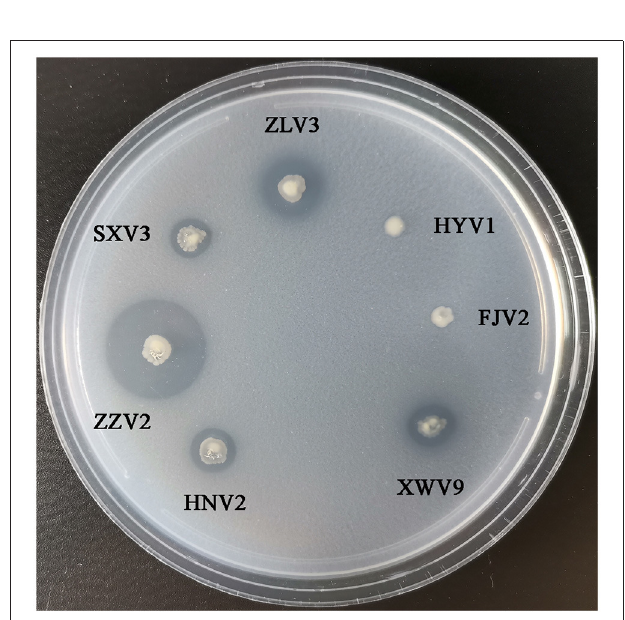
FIGURE 9 | The growth performance of the seven V. alginolyticus strains on medium containing chitin as sole source of carbon-nitrogen.